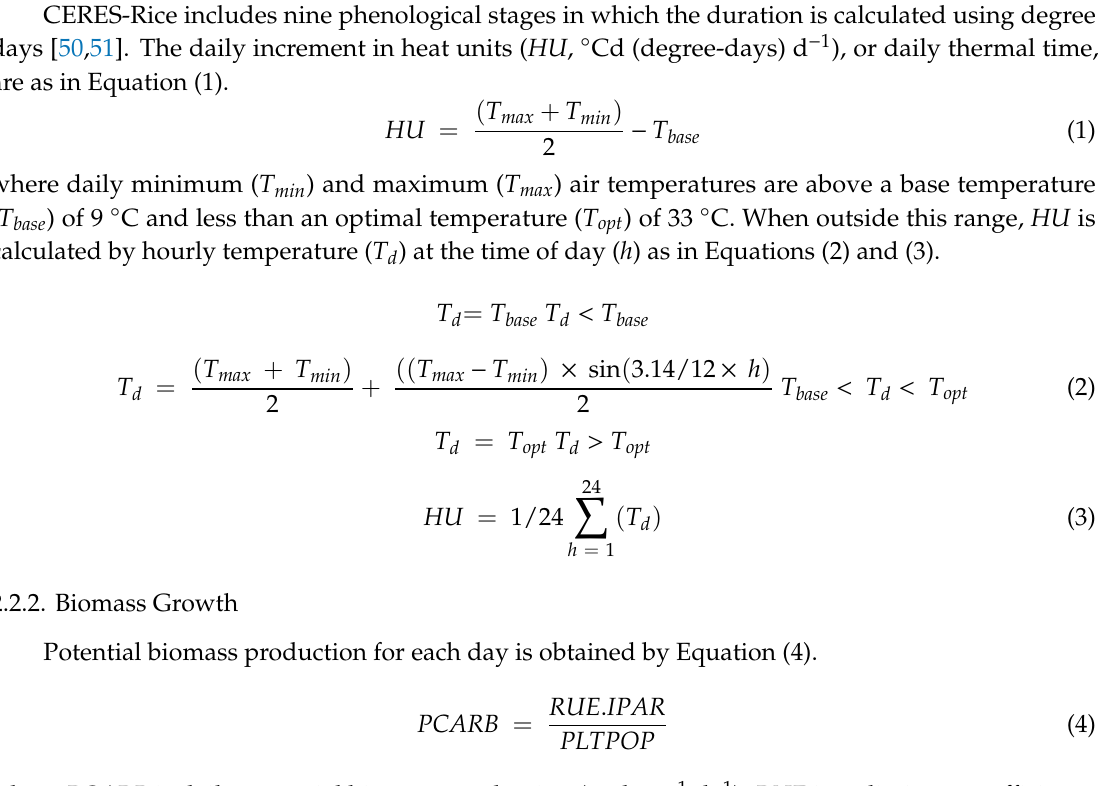
Table 1. Observed climate and rice yield from four representative locations in the Uniform Regional Rice Nursery (URRN) database from 1983 to 2016. Seasonal averages for daily mean temperature (Tmean), rainfall, and yield averaged across 101 varieties were shown. Trends indicating the increase in maximum (Tmax) or minimum temperature (Tmin), and the 50% percentile yield of 101 varieties (Yield) versus time were computed as the slope of the linear regression of the response variable versus year. Site Beaumont, TX Crowley, LA Stuttgart, AR Stoneville, MS Latitude, Longitude 30.07, − 94.29 30.24, − 92.38 34.5, − 91.55 33.43, − 94.28 Tmean ( ◦ C) 25.7 ± 0.64 25.5 ± 0.6 25.1 ± 0.76 25.7 ± 0.79 Rainfall (mm) 1033 ± 288 744 ± 372 424 ± 132 467 ± 134 Mean yield (kg ha -1 ) 7919 ± 1849 8388 ± 1463 8195 ± 1387 8509 ± 1646 Trend in Tmax ( ◦ C decade − 1 ) 0.01 0.01 0.1 0.44 (**) Trend in Tmin ( ◦ C decade − 1 ) 0.60 (**) 0.43 (**) 0.41 (**) 0.33 (**) Trend in Yield (kg year − 1 ) 116 (**) 93 (**) 63 (**) 144 (**) ** Correlation is significant with p <